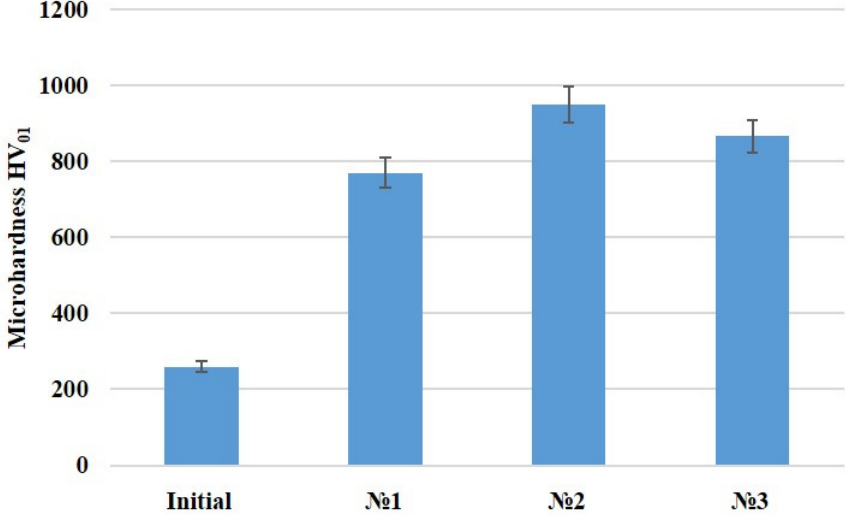
Figure 4. Vickers micro-hardness of the samples in different